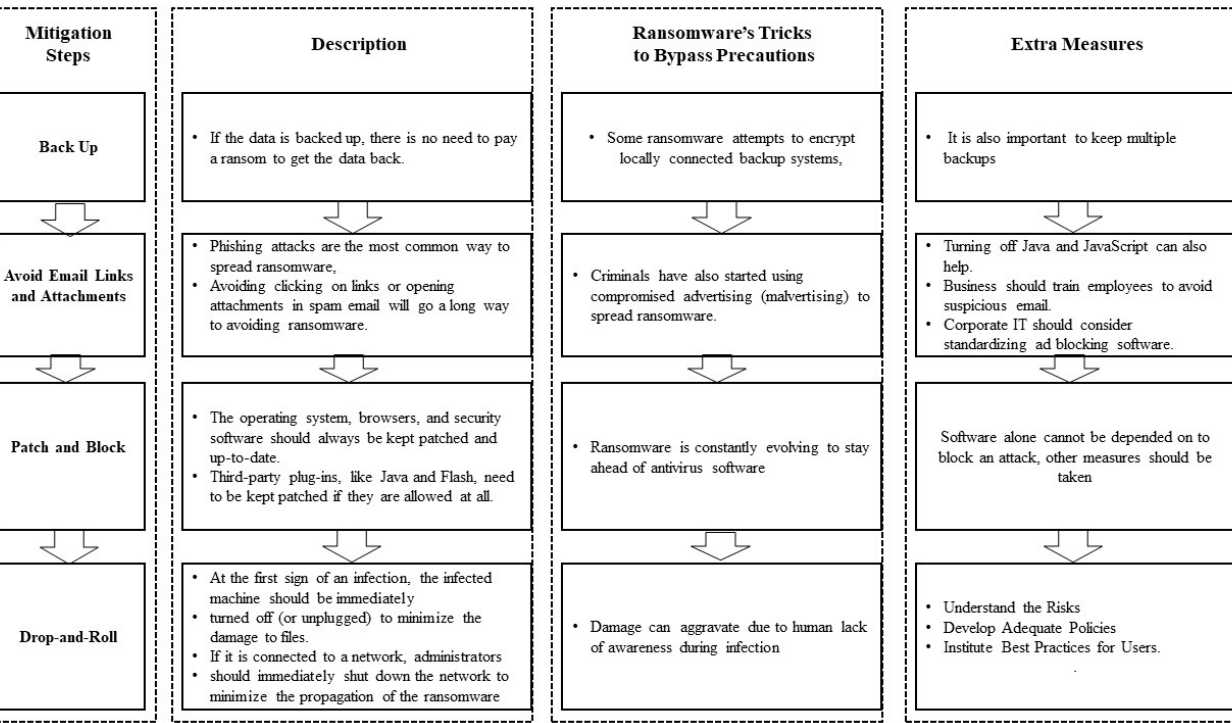
Figure 16. Ransomware mitigation for organizations and individuals.